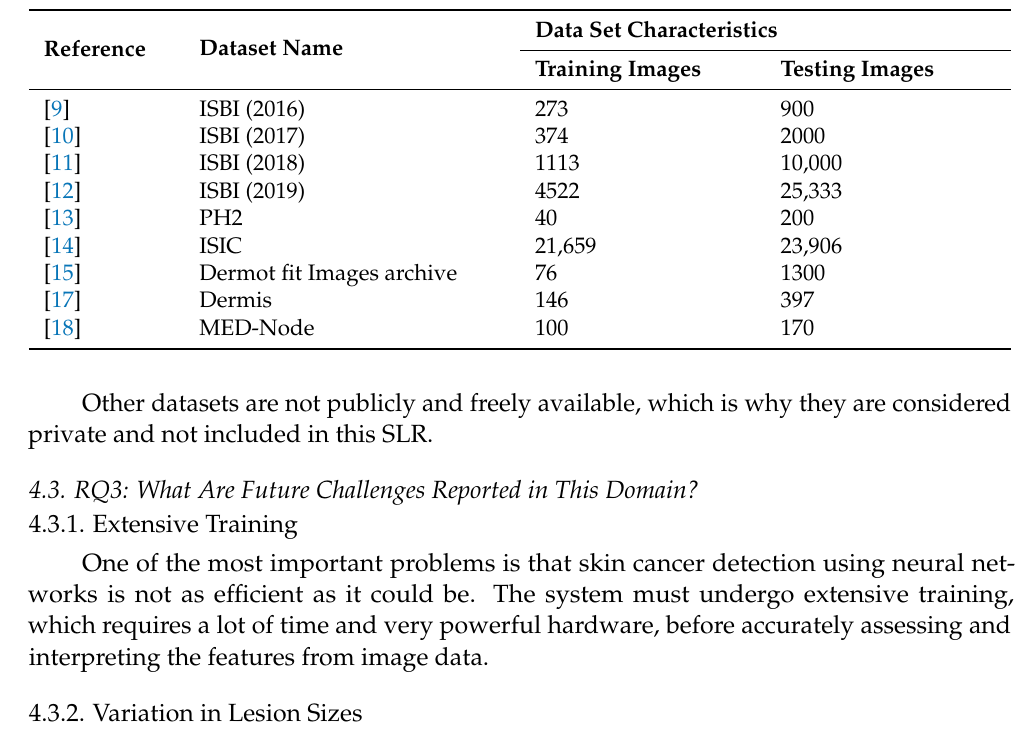
Table 8. A list of publicly available datasets for skin cancer